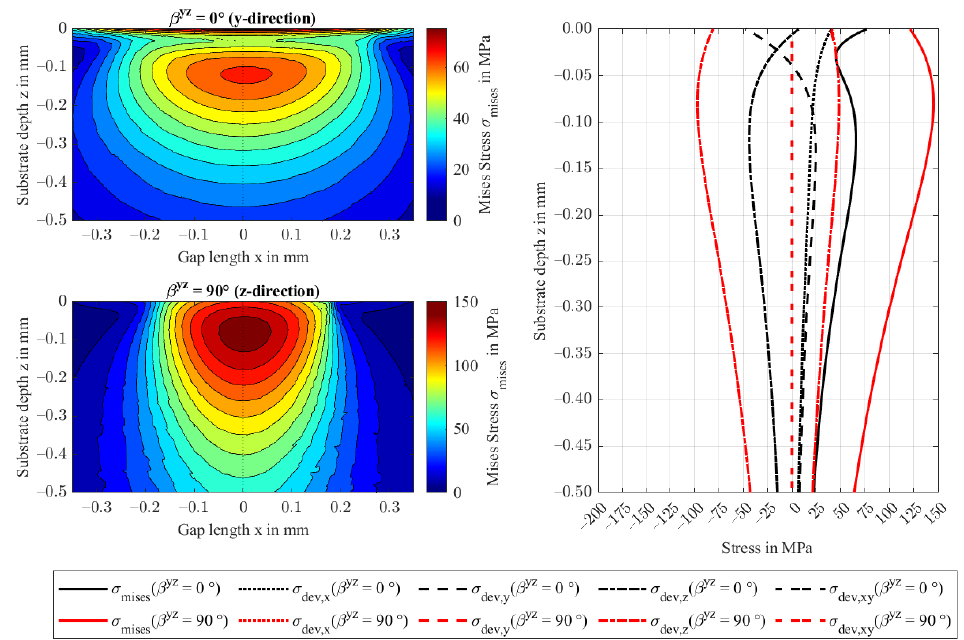
Figure 17. von Mises stresses in the yz-plane at y = 0 for β yz = 0 and 90 ◦ ( left ) and the respective principal stresses at the contact center of the FRP in substrate depth direction z ( right ).